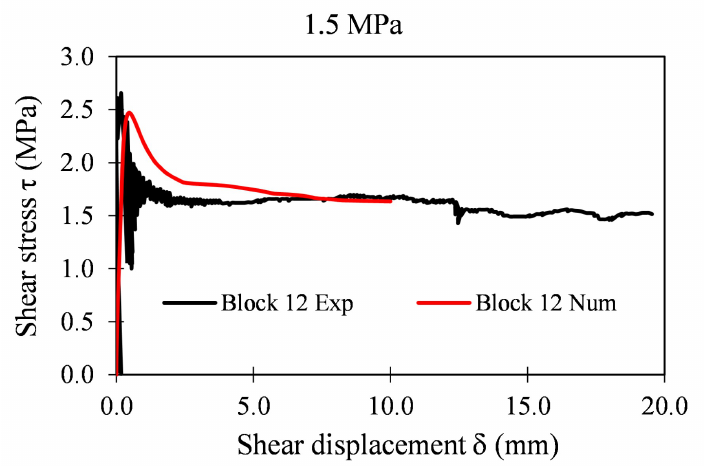
Figure 32. Shear stress evolution with displacement Exp–Num (Block 11).